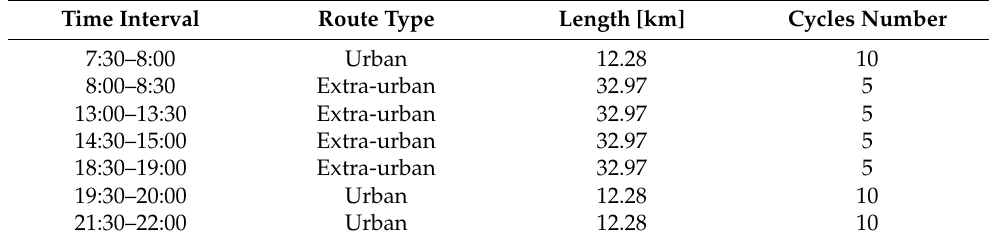
Table 4. Mobility pattern 2 definition.